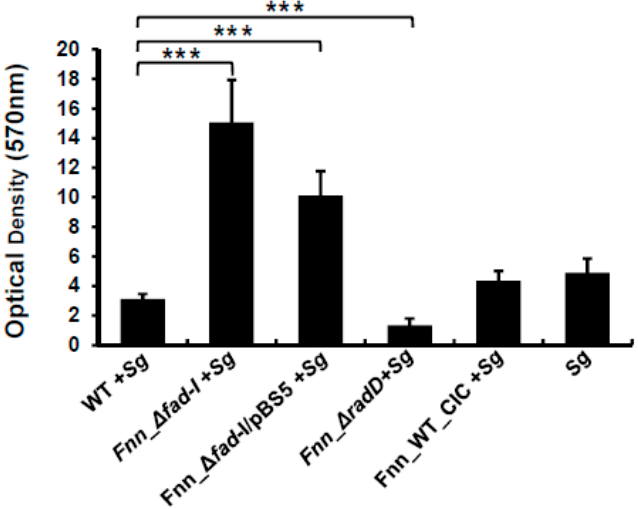
Figure 7. Biomass of dual-species biofilms formed by F. nucleatum ssp nucleatum ATCC 23726 and its radD -operon mutant derivatives with S. gordonii . The biomass was assessed via the crystal violet assay. Data are presented as the mean and standard error of mean of three independent experiments (*** represents p ≤ 0.001).